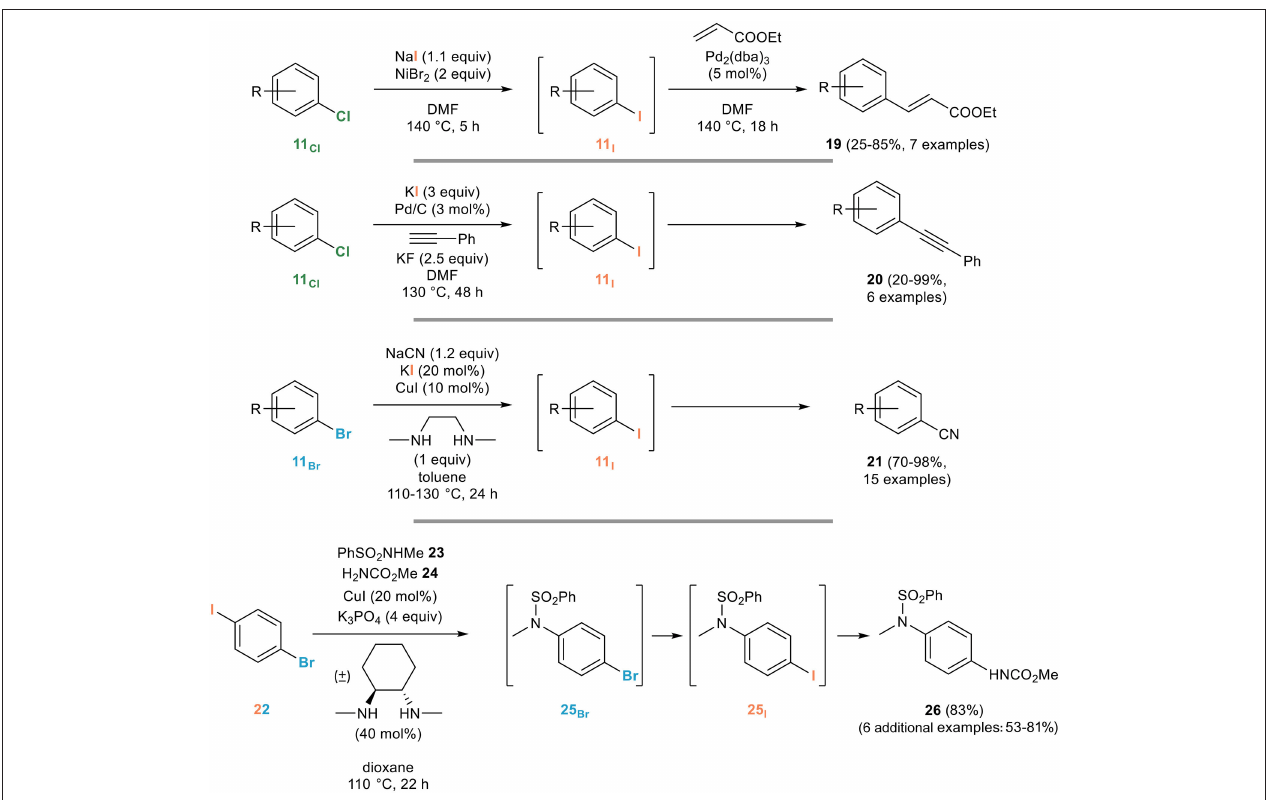
FIGURE 14 | Representative applications of the aromatic Finkelstein reaction for the in situ generation of reactive aryl iodides.